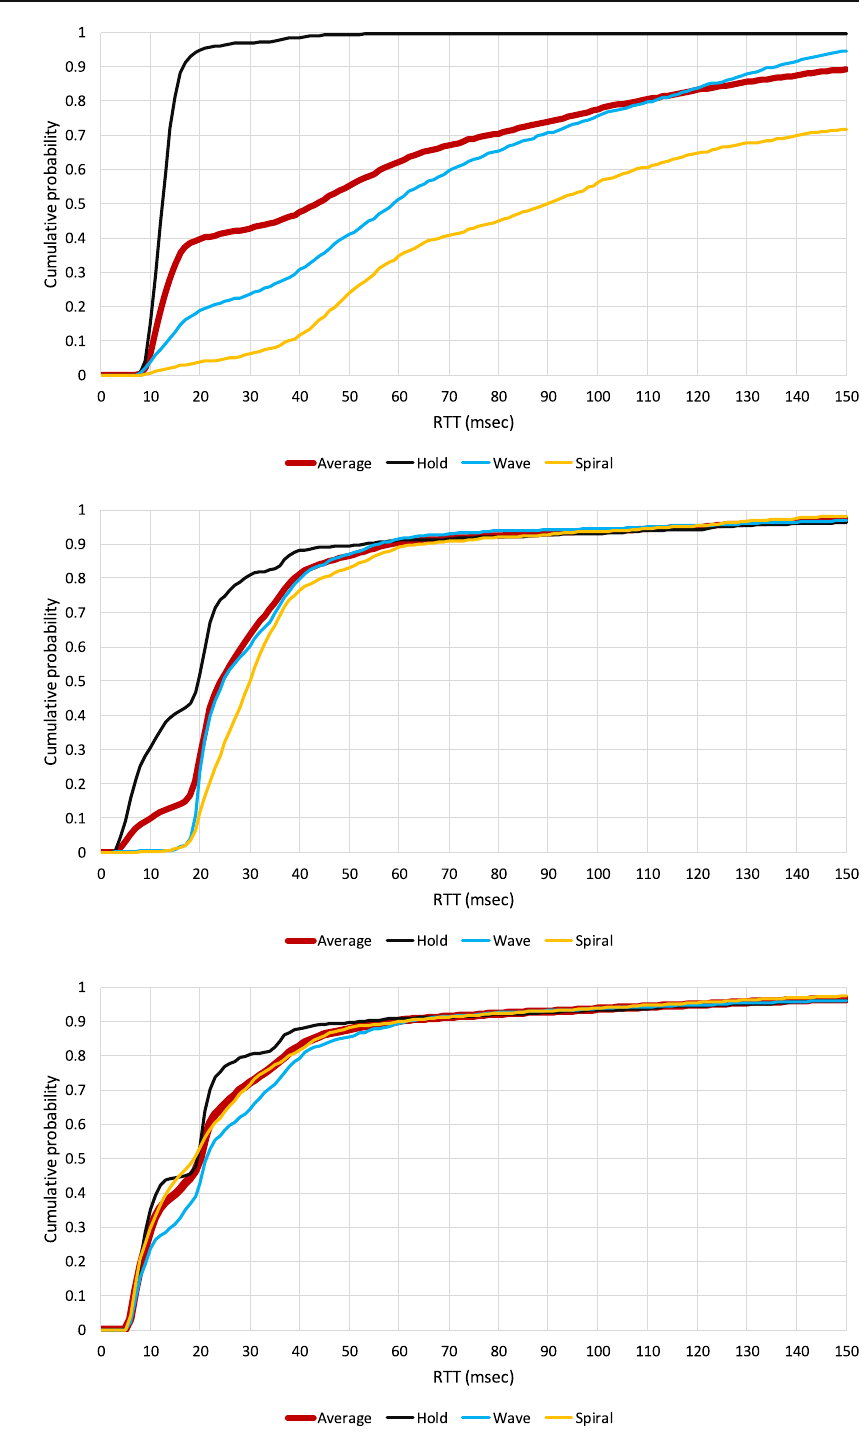
Fig. 4 All-RTT in Wi-Fi (comparison based on drawing operations)